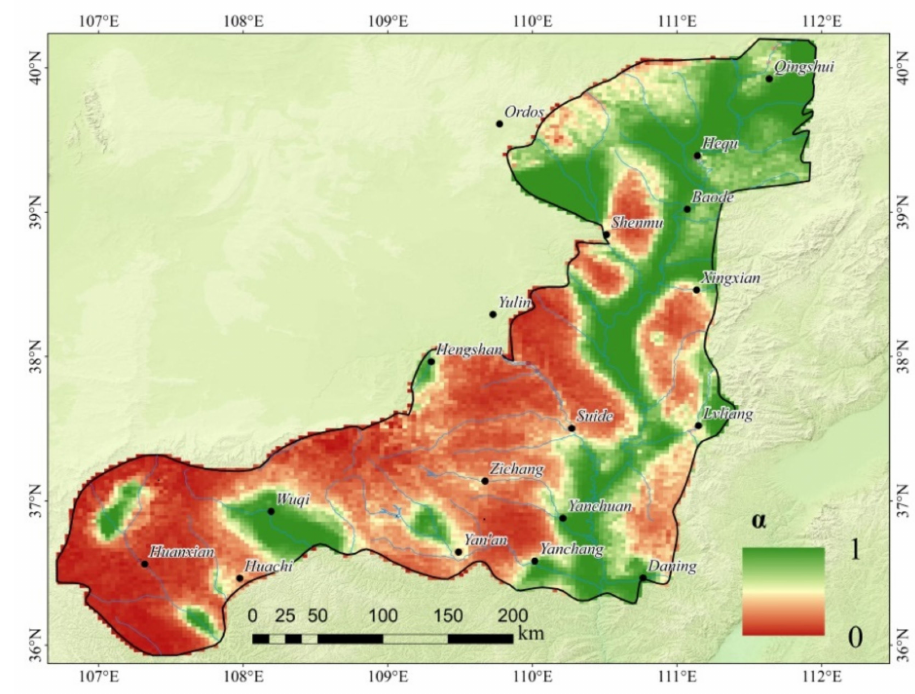
Figure 8. Spatial distribution map of coefficient of relative